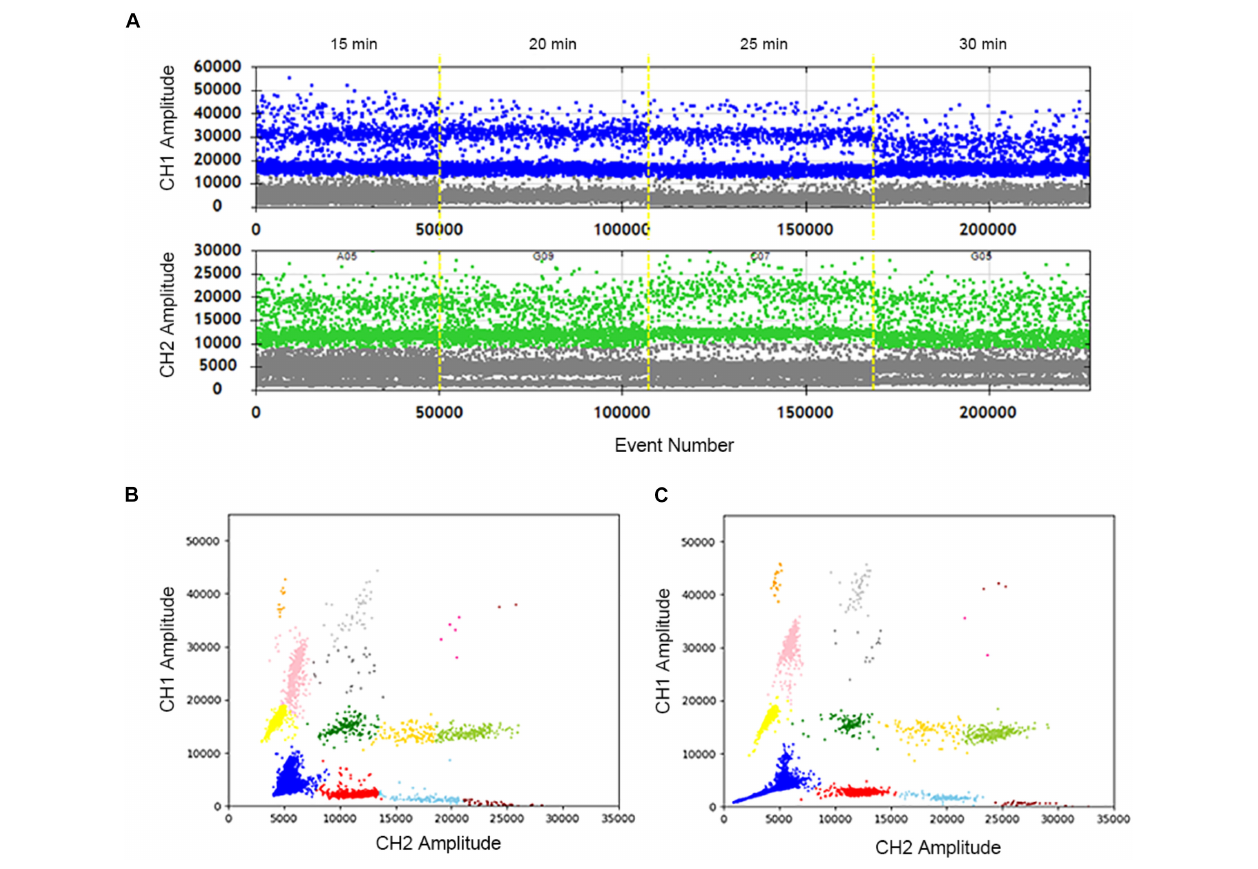
FIGURE 2 | Optimization of the sample hot lysis time in two channels and 2D plot. (A) The positive droplets were represented as blue and the negative droplets were represented as gray in FAM. The positive droplets were represented as green and the negative droplets were represented as gray in VIC. (B) The 2D plot was obtained in 30 min of the hot lysis time. (C) The 2D plot was obtained in 25 min of the sample hot lysis